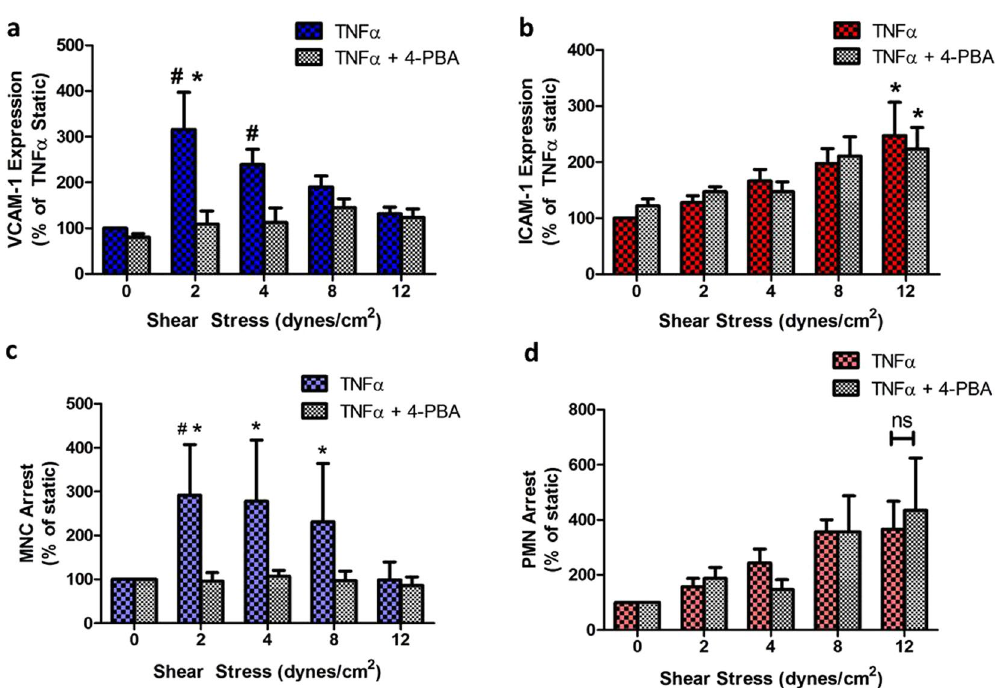
Figure 3. SS-modulation of TNF α -induced VCAM-1 expression is ER stress-dependent. HAEC were exposed to TNF α and SS for 4 hrs in the presence or absence of an inhibitor of ER stress, 4-PBA, and immunolabeled for ( a ) VCAM-1 or ( b ) ICAM-1. Isolated ( c ) mononuclear cells (MNC) and ( d ) polymorphonuclear neutrophils (PMN) were flowed over preconditioned HAEC and firmly arresting cells were enumerated. Values are mean ± SE, n = 3–5, # P < 0.05 vs static TNF α . * P < 0.05 vs same